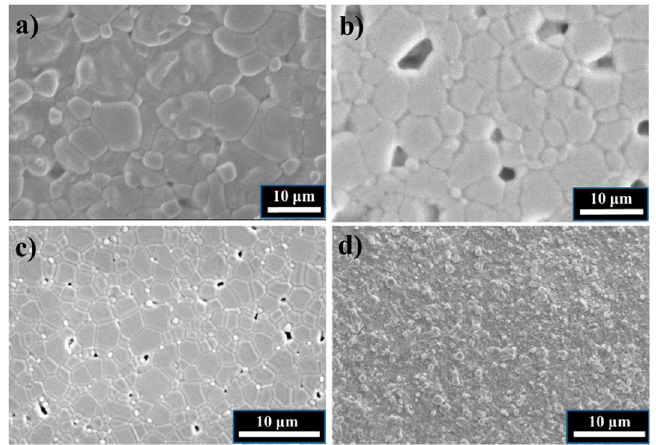
Figure 1. The microstructure of the sintered and thermally etched ( a ) CZ; ( b ) SZ; ( c ) BZ ceramics; and ( d ) 96 ZrO 2 layer deposited on the surface of ceramics. Pores in ( b ) are due to grain pull out during polishing. Table 1. Crystal structure, unit cell parameters, grain size, and relative density of the three materials BZ, SZ, and CZ.